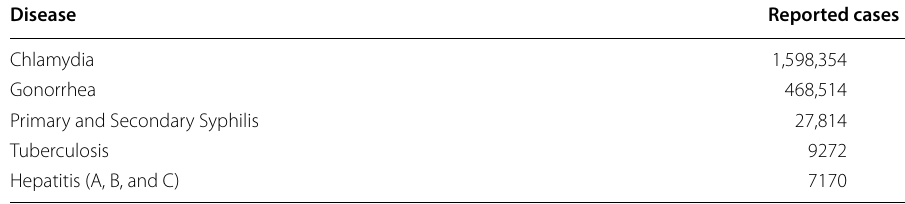
Table 11 CDC reported cases for the infectious diseases included in AtlasPlus in 2016